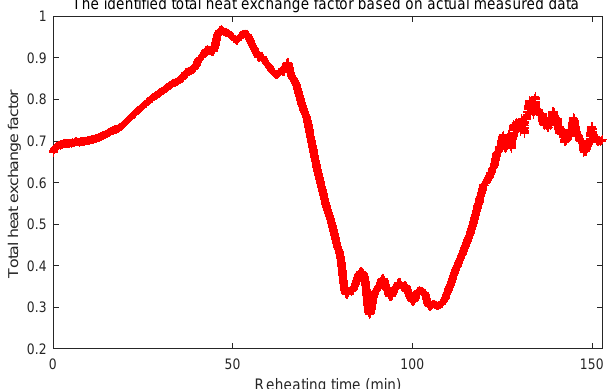
Figure 14. The identified total heat exchange factor based on actual measured